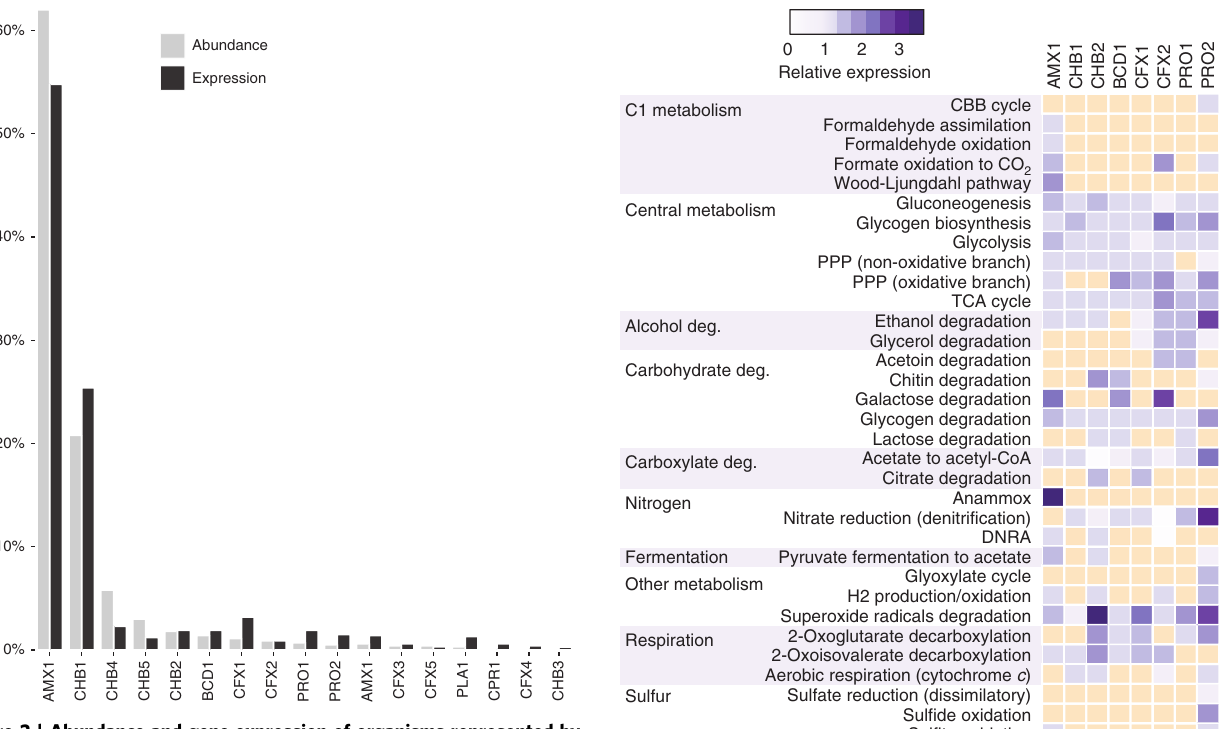
Figure 2 | Abundance and gene expression of organisms represented by the MAGs recovered from the anammox bioreactor. Abundance and gene expression estimates were based on RPKM values of metagenomic reads and transcripts that mapped to each MAG, respectively. See Supplementary Table 2 for mapping details.